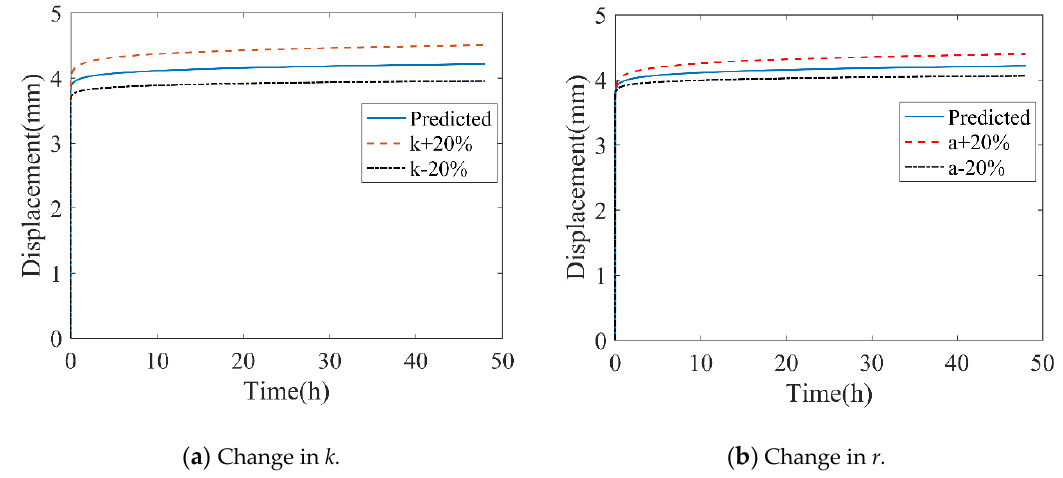
12 of 20 Table 2. Expression of error evaluation indexes. Error Index